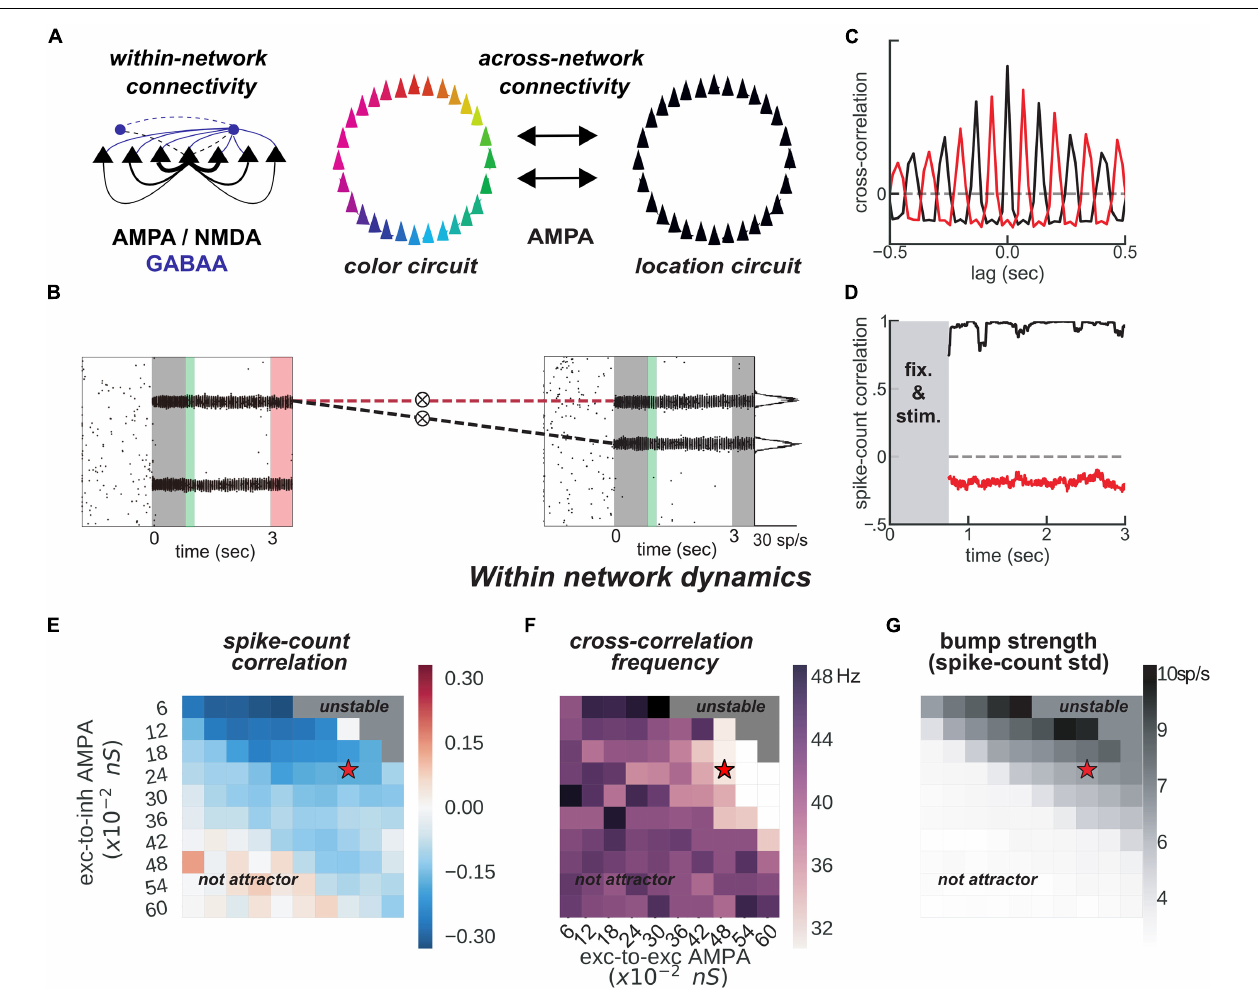
FIGURE 3 | Feature-binding through weak, uniform coupling of 2 ring attractors. (A) Left, schematics of within-network excitatory (black) and inhibitory (blue) connectivity to excitatory (solid) and inhibitory (dashed) neurons. Neurons with similar selectivity were strongly connected as illustrated by the line width. Right, schematics of the 2-network architecture, consisting of 2 ring-attractors with all-to-all, uniform connectivity. Each ring is able to store memories from one feature space (e.g., color or location) as activity bumps ( Figure 1 ). (B) One example simulation for the two networks. The pink-shaded area marks the period in which we read out the activity of the entire color network, while injecting current at one specific location in the location network (right gray-shaded area in the location rastergram, see main text for details about encoding/decoding). (C) Cross-correlation computed between 2 pairs of bumps across networks [as marked with dashed red and black lines in panel (B) ]. Across networks, oscillating bumps synchronize in phase (black, positive zero-lag cross-correlation) or out of phase (red, negative zero-lag cross-correlation). (D) Spike count correlation (in count bins of 5 ms and correlation windows of 100 ms) of both associations through the memory delay is stable for this simulation. (E,F) Similar to Figures 1B,D , but manipulating AMPAR conductances across networks. (E) Robustness of anti-phase dynamics within each network as measured by spike count correlation between bumps ( Figure 1B ). (F) Dominant frequency of cross-correlation between the two bumps within each network ( Figure 1D ). (G) Bump strength measured as standard deviation of spike-counts across model neurons at the end of the delay. (E–G) summarize the dynamics of 22,000 simulations (total) of 100 × 2 networks. Stars indicate parameters and dynamical regime of network simulations shown in panels (B–D)